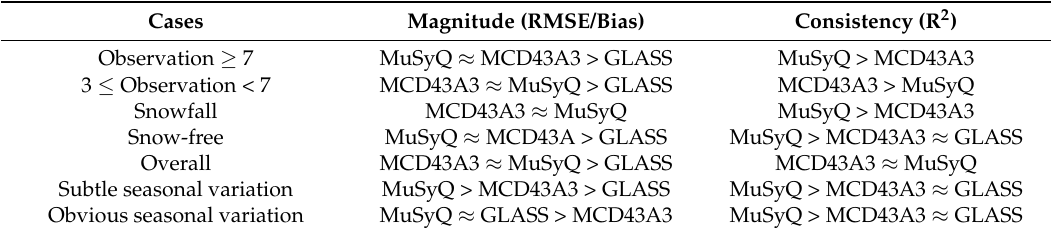
Table 5. The rank orders of the performances of MCD43A3, GLASS and MuSyQ albedo in different